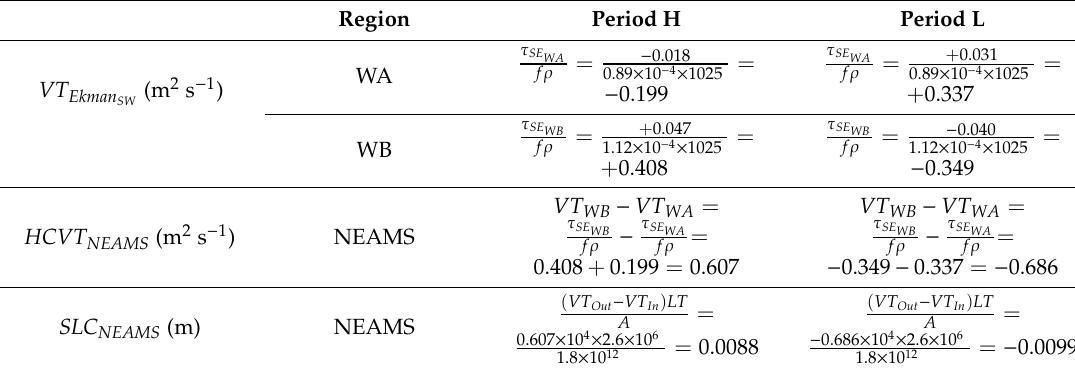
Table 1. Scaling estimation for southwestward Ekman transport per unit horizontal length scale within ) , horizontal convergence / divergence due to net volume transport the surface Ekman layer ( VT Ekman SW into / out of the NEAMS per unit horizontal length scale ( HCVT NEAMS ), and NEAMS-mean sea level change ( SLC NEAMS ) in Periods H and